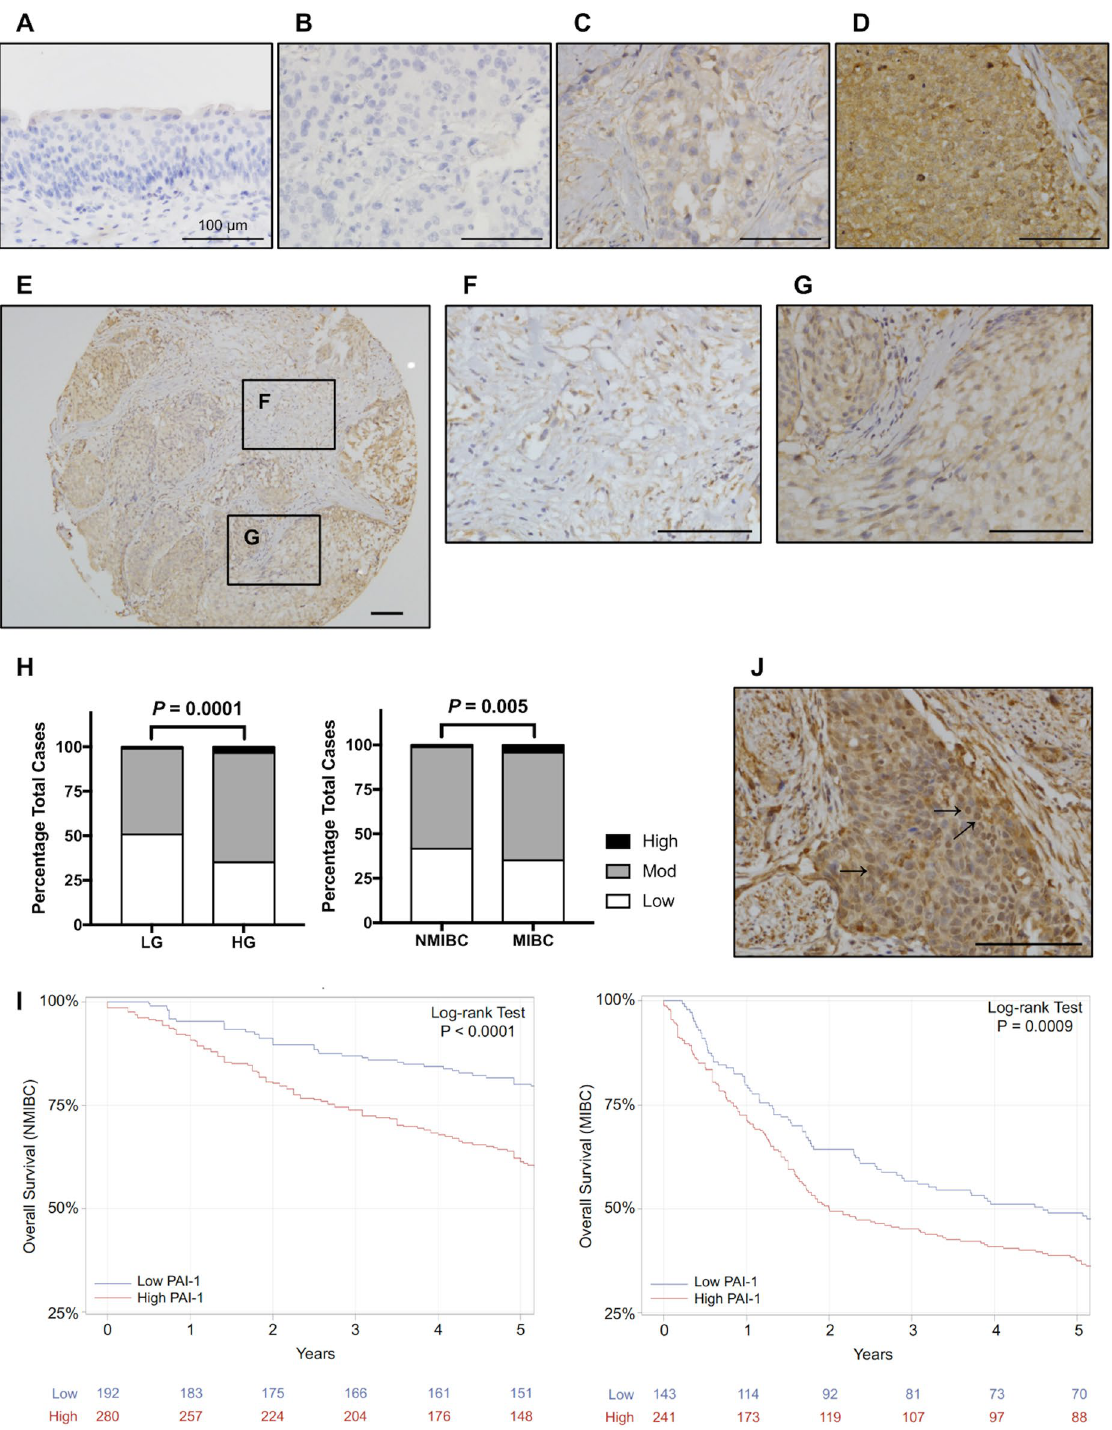
Figure 1. PAI-1 expression is increased in bladder cancer. Representative images of normal urothelium ( A ) and of bladder cancers with absent ( B ), weak ( C ) and strong ( D ) PAI-1 expression (brown) are shown. Representative images of a sample TMA core ( E ), PAI-1 expression in the tumor-associated stroma ( F ) and PAI-1 expression in the tumor epithelia ( G ). Scale bars, 100 μm. ( H ) Quantification of PAI-1 expression levels in low-grade (LG) vs . high-grade (HG) and NMIBC vs . MIBC. ( I ) Correlation between PAI-1 expression and overall survival in NMIBC and MIBC. Data are from analysis of a TMA containing 939 bladder tumors. ( J ) PAI-1 expression is noted in the nucleus and